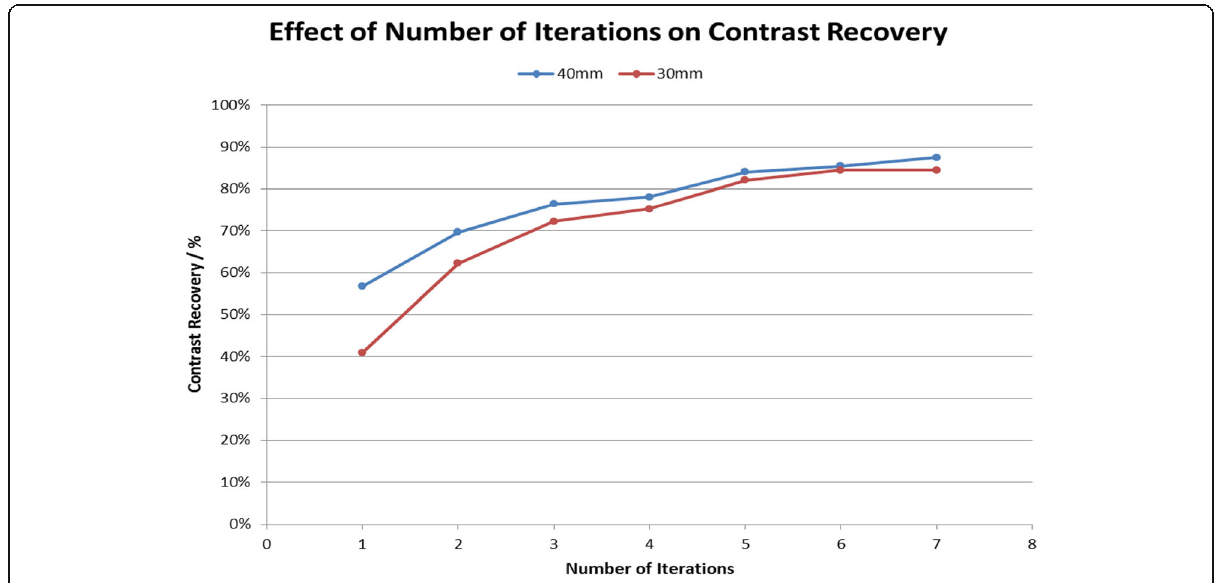
Fig. 2 Number of iterations plotted against contrast recovery for the 40- and 30-mm sphere sizes. The number of subsets was